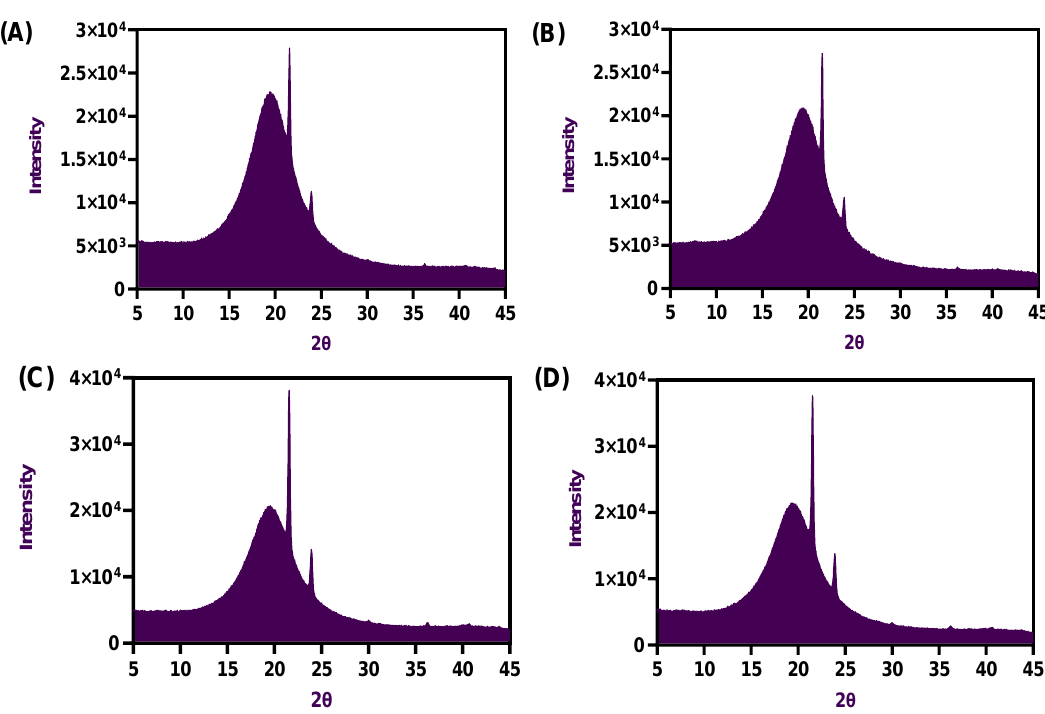
have more dense structures. Szymanska et al. [32] reported that oleogels’ morphological observations are critically influenced by their compositions, particularly crystalline sizes, which are categorized as small, medium, and maximum. Small, crystalline-like oleogels normally exhibited dense and firm networks. Yu et al. [33] found that the application of ultrasonication in the oleogel preparation led to forming a small crystalline network in the oleogels. Figure 5. XRD patterns of palm oil-based oleogels (OG1 ( A ), OG2 ( B ), OGU1 ( C ), and OGU2 ( D )) prepared with different concentrations of carnauba wax and the ultrasonication process.